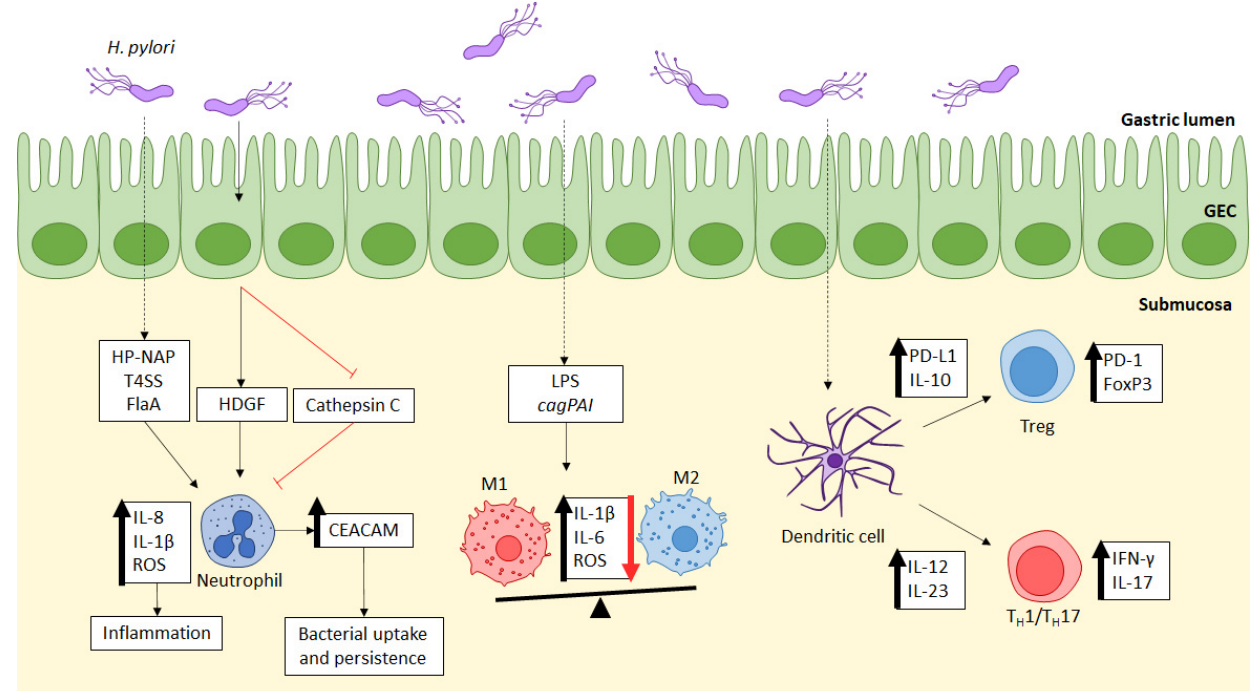
Figure 2. Innate immune cells interaction with H. pylori across gastric epithelial cells (GECs). Neu- trophils are directly activated by bacterial antigens, including H. pylori neutrophil activating protein (HP-NAP), type IV secretion system (T4SS), and flagellin A (FlaA), or indirectly through gastric epithelial cells secretion of hepatoma-derived growth factor (HDGF). Activation may result in proin- flammatory cytokines secretion (IL-8 and IL-1 β ) and the production of reactive oxygen species (ROS) for the clearance of bacterial load. H. pylori can inhibit cathepsin C production to dampen neutrophil activation. It can also lead to cellular carcinoembryonic antigen-related cell adhesion molecules (CEACAMs) expression, which enhances neutrophils phagocytic activity without bacterial killing. Macrophages can be activated by bacterial lipopolysaccharide (LPS) or by the presence of the viru- lence gene cag pathogenicity island (cagPAI), resulting in mixed polarization of proinflammatory (M1) with high expressions of IL-1 β , IL-6, and ROS, and the anti-inflammatory (M2) macrophages. Dendritic cells process bacterial antigens that are presented to T cells for differentiation. These cells upregulate programmed death ligand 1 (PD-L1) on regulatory T cell (Treg) to increase IL-10 secretion, leading to bacterial persistence. It can also upregulate proinflammatory cytokines IL-12 and IL-23 to stimulate T helper 1 (T H 1) and 17 (T H 17) polarization, which releases high amounts of interferon- γ (IFN- γ ) and